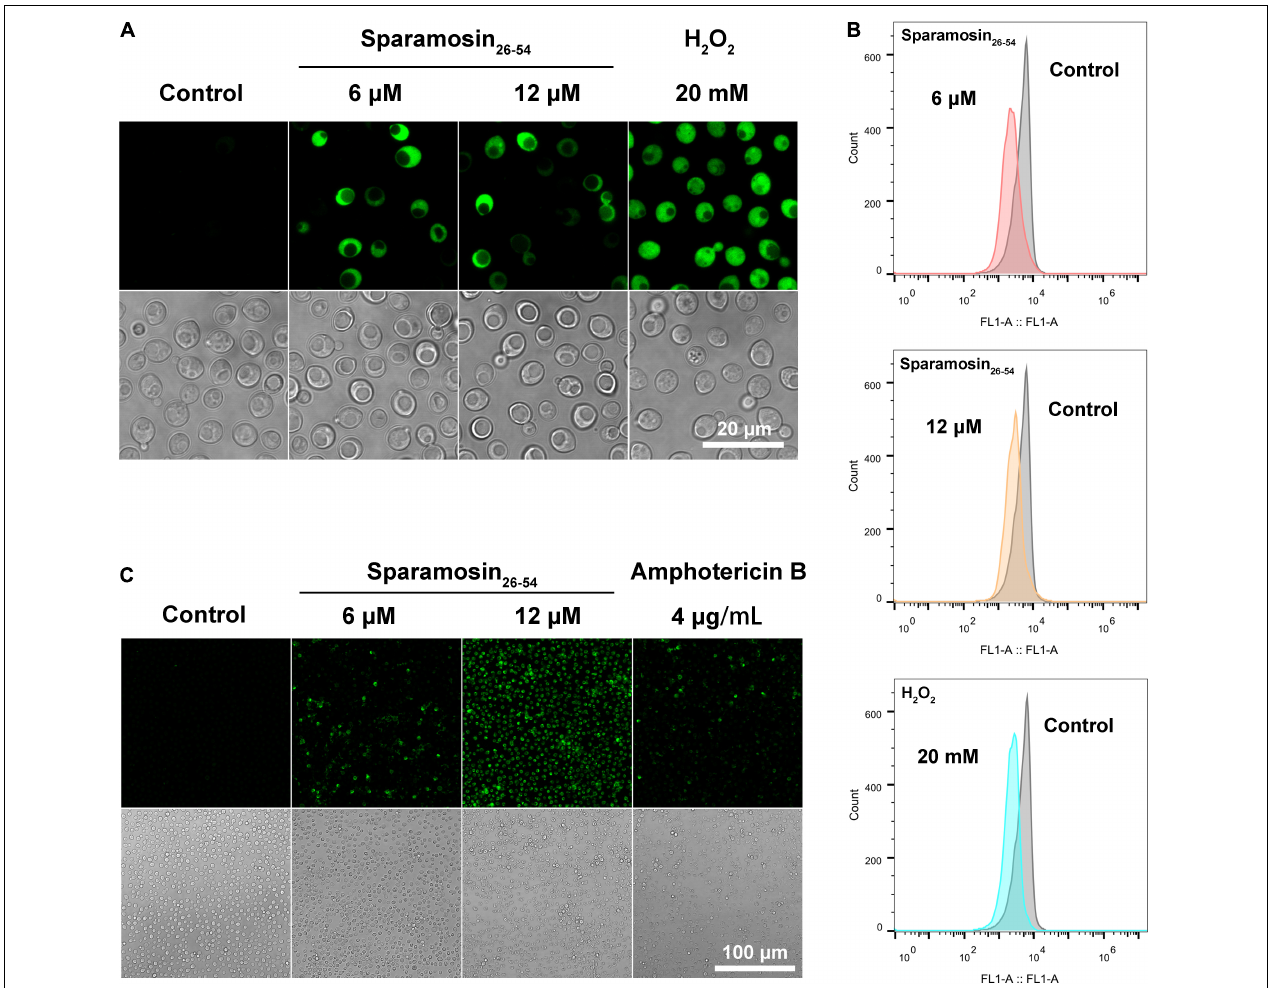
FIGURE 7 | Sparamosin 26 - 54 induces apoptosis in C. neoformans . (A) Detection of intracellular ROS accumulation in Sparamosin 26 - 54 -treated C. neoformans using DCFH-DA. (B) Analysis of mitochondrial membrane depolarization in C. neoformans after Sparamosin 26 - 54 treatment. (C) Analysis of DNA damage in Sparamosin 26 - 54 -treated C. neoformans by the TUNEL